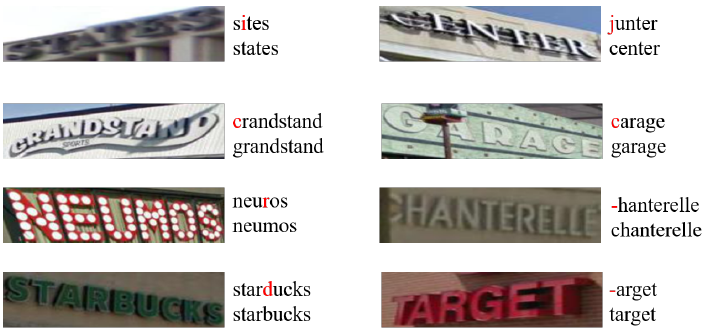
Figure 6. Right cases of TRIG with/without initial embedding guided. The predictions are placed along the right side of the images. The top string is the prediction of TRIG without the initial embedding guidance. The bottom string is the prediction of TRIG.